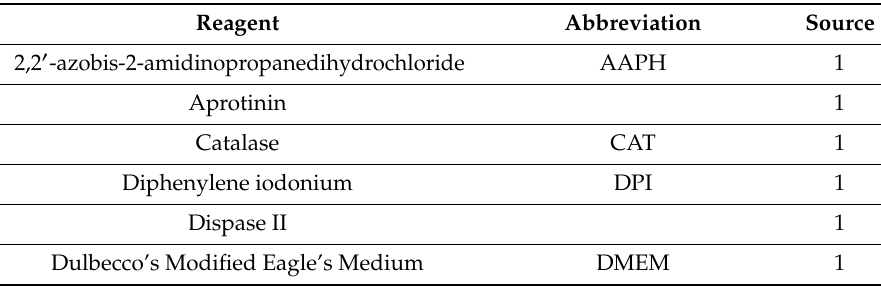
Table 1. Reagents used in the